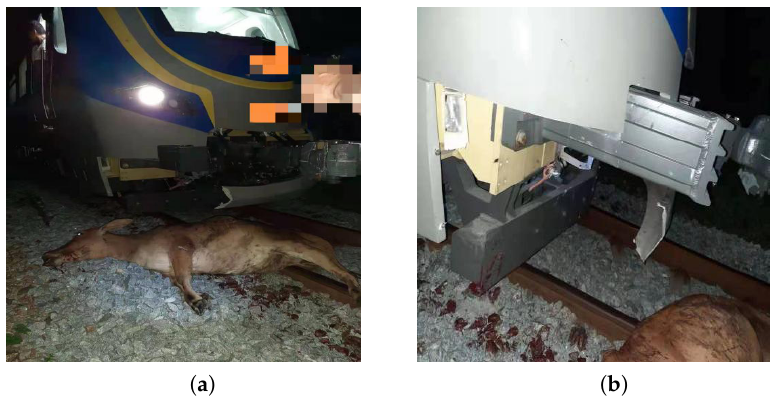
Figure 1. Collision between a train and a liveintruder in a Southeast Asian country: ( a ) Collision with a live intruder; ( b ) Train front-end